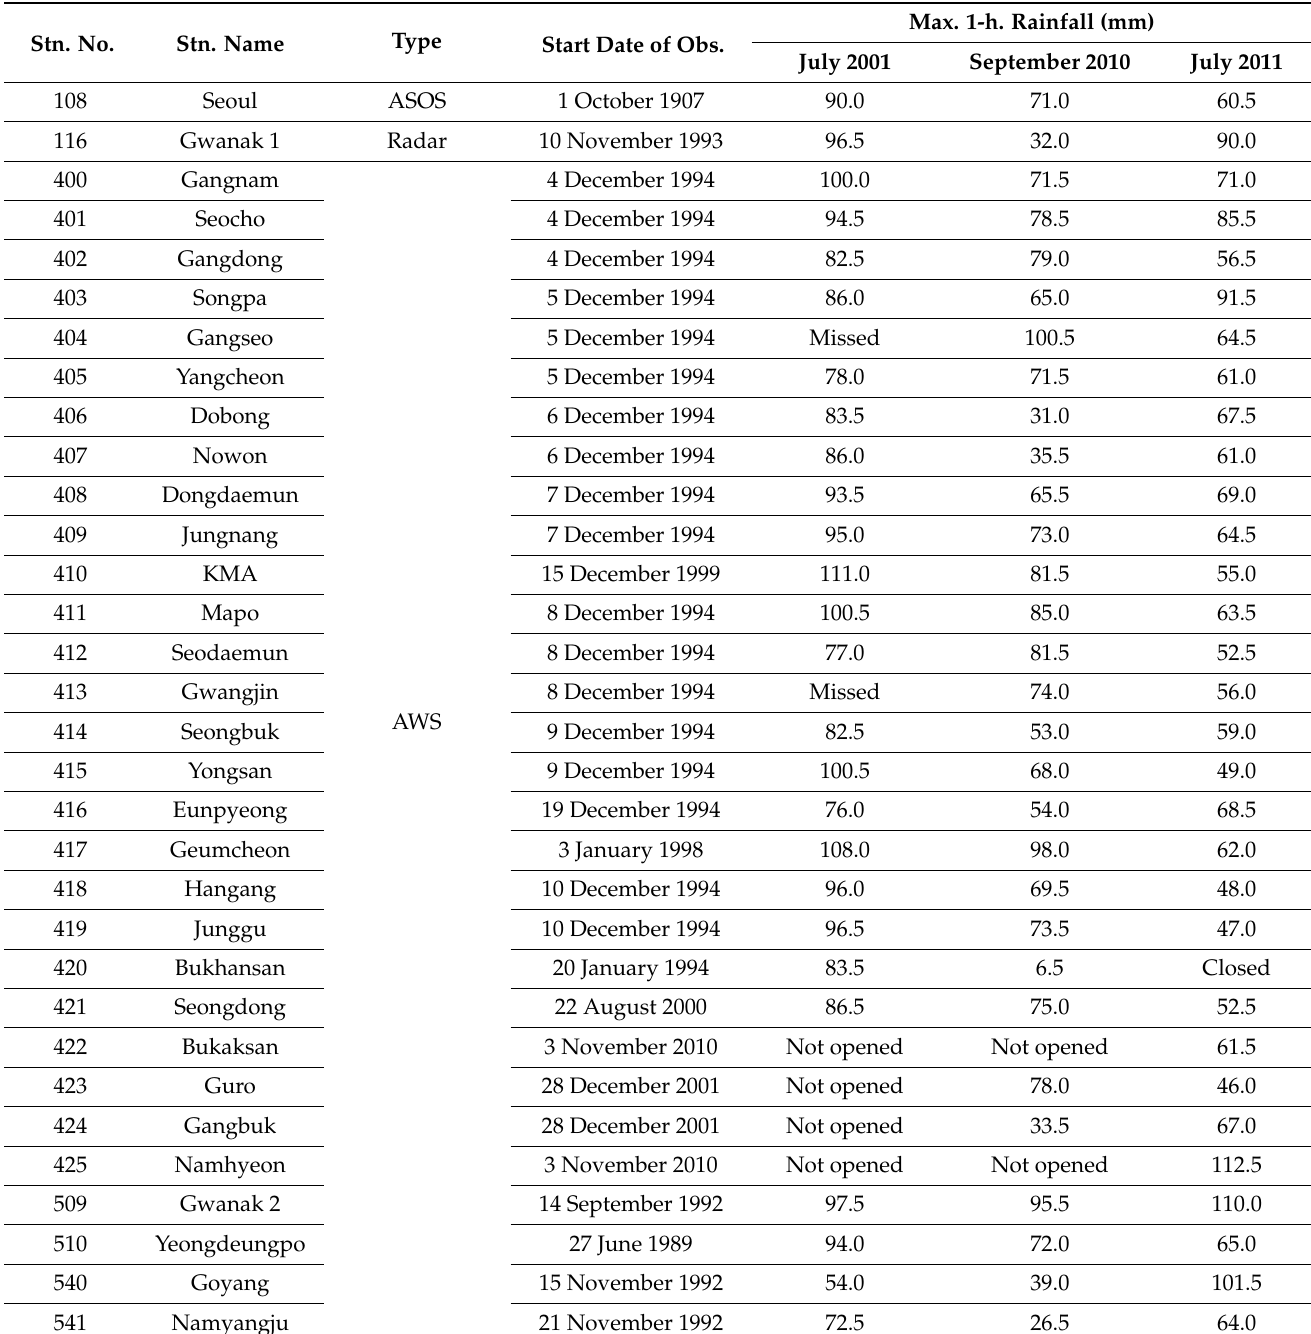
Table 1. Observatories in Seoul and maximum 1-h.